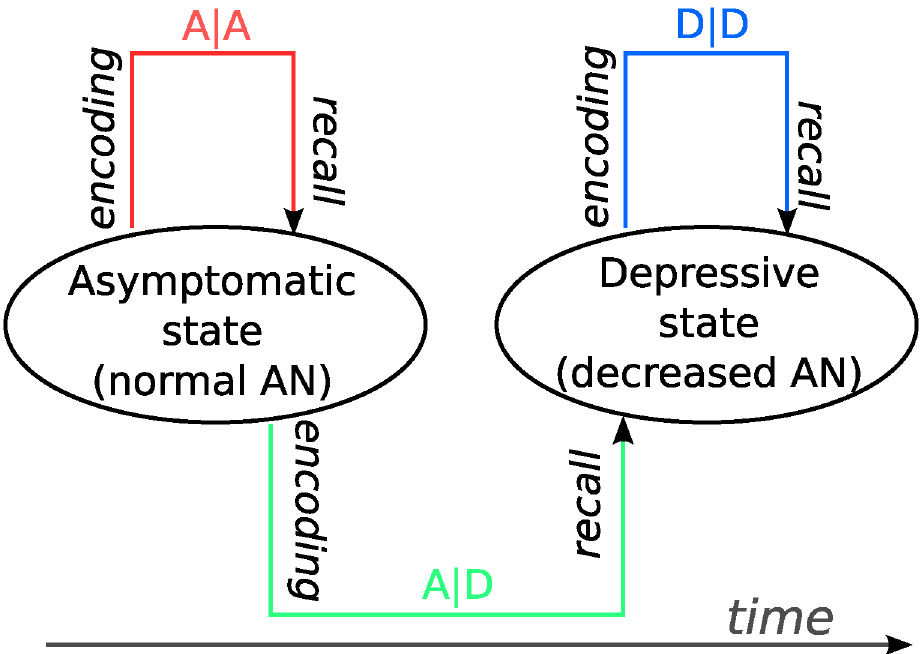
Fig 3. Three scenarios of memory storage and retrieval in the model. The rate of adult neurogenesis (AN) is normal in the asymptomatic state and reduced in the depressive state. The origin of the arrow indicates during which state the memory was stored, and the termination of the arrow indicates during which state the memory is retrieved. A|A: memories stored and retrieved in the asymptomatic state; A|D: memories stored in the asymptomatic state and retrieved in the depressive state; D|D: memories stored and retrieved in the depressive state.